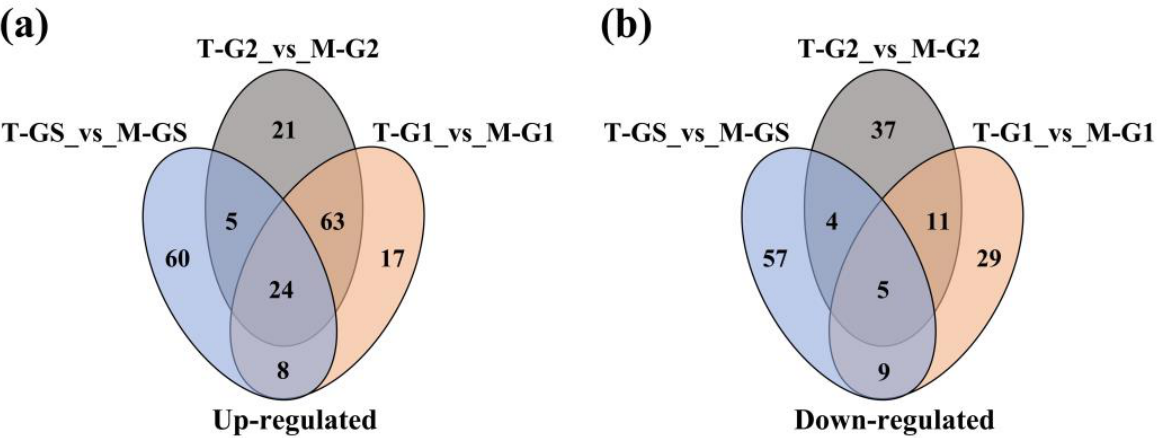
Figure 5. Differential compounds of Shandong matcha made from different grades of tencha. ( a ) Number of up-regulated differential compounds. ( b ) Number of down-regulated differential com- pounds.